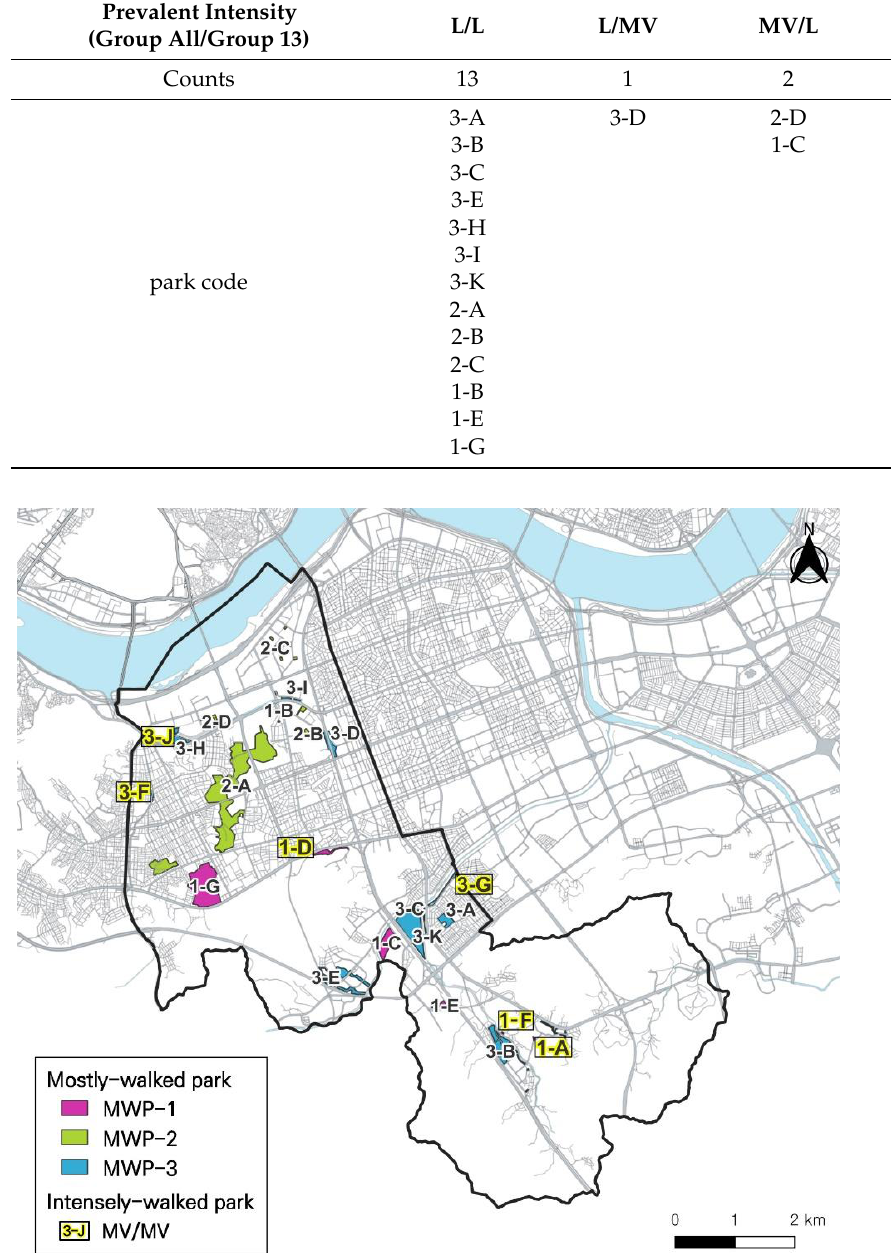
Figure 4. Map visualization of ‘well - walked